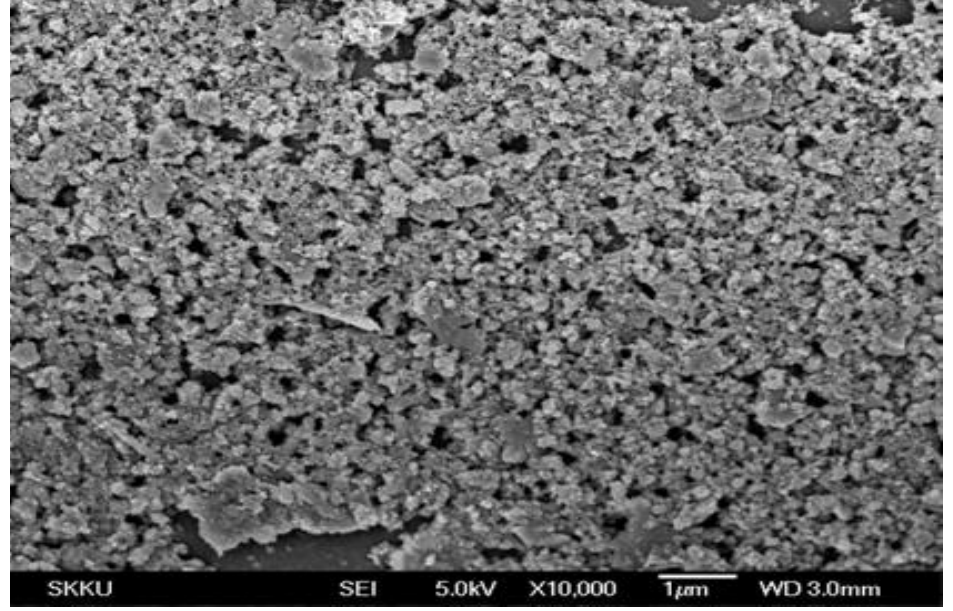
O nanocomposite. 2 4